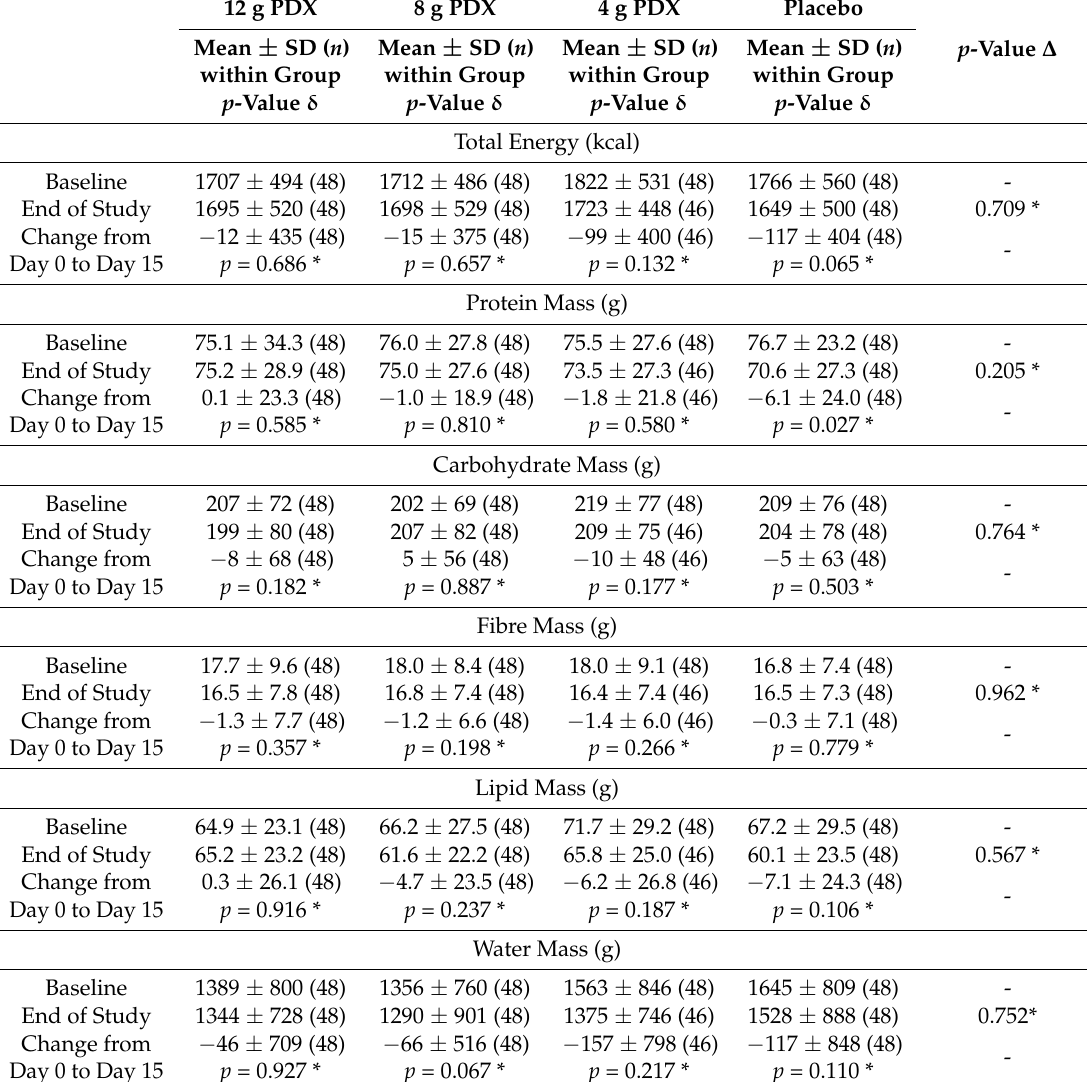
Table 2. Average 3-day food record results previous to baseline (Day 0) and previous to end of study (Day 15) for participants in the intention-to-treat population ( n =